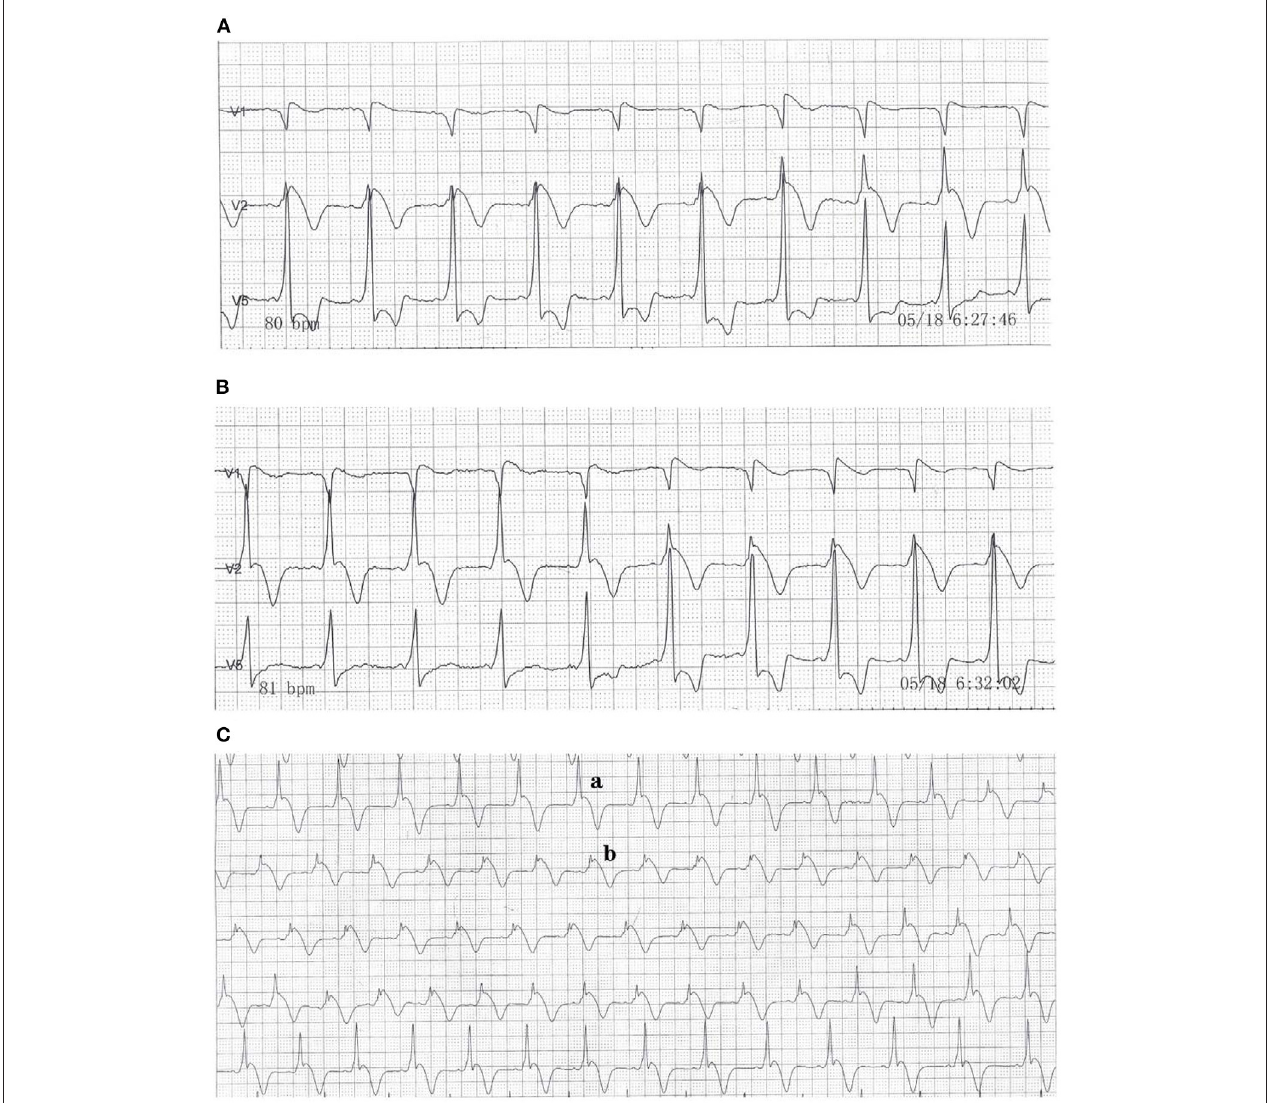
FIGURE 2 | Dynamic electrocardiogram that shows one cycle of the QRS complex. (A) The QRS complex began to change in leads V1, V2, and V5 at 6:27a.m. (B) The change ended at 6:32a.m. (C) Dynamic electrocardiogram that shows the continuous changes in the QRS complex in lead V2.